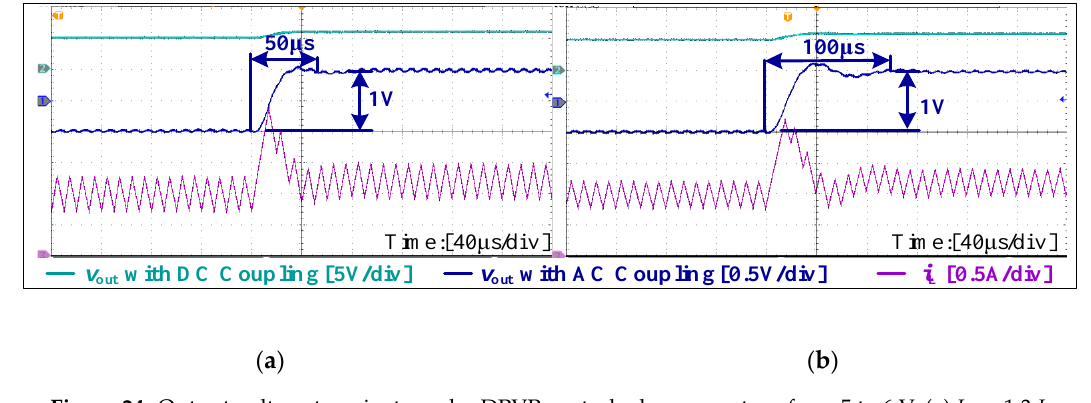
Figure 23. Output voltage transients under DPVP control when v in steps from 12 to 9.5 V: ( a ) L a = 1.3 L and ( b ) L a = 1.6 L.